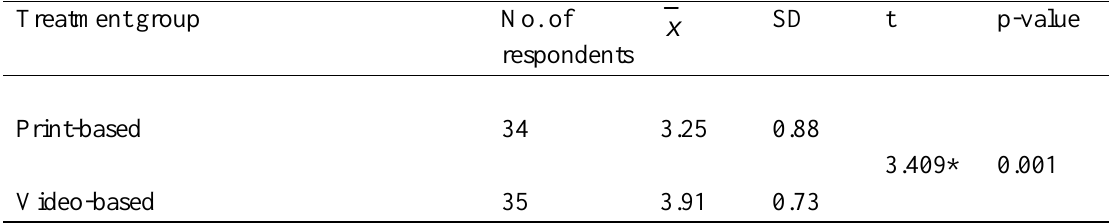
Results of T-Test Analysis for Craftsmanship Displayed Treatment